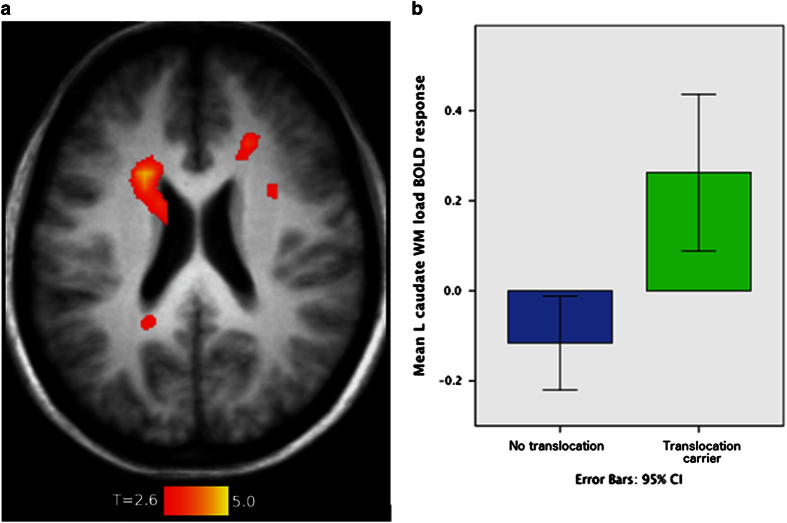
Differential brain activation during increasing working memory load between translocation carriers and non-carriers. The effects of increasing working memory load (from 0- to 1- to 2-back) in the N-back task on functional MRI comparing t(1;11) translocation carriers and non-carriers, controlling for age and sex. (a) Transverse slice (z=22) displaying the statistically significant group×load interaction in left caudate, a family-wise error-corrected P<0.05. (b) Contrast estimates in the left caudate for 2-back>0-back for t(1;11) carriers and non-carriers to indicate the size of the effect.